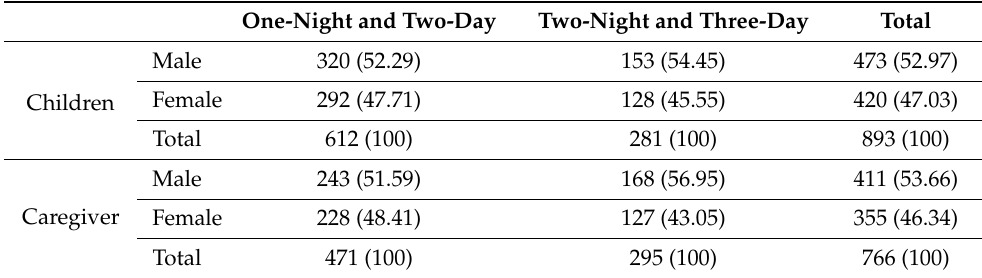
Table 1. Subject general characteristics.